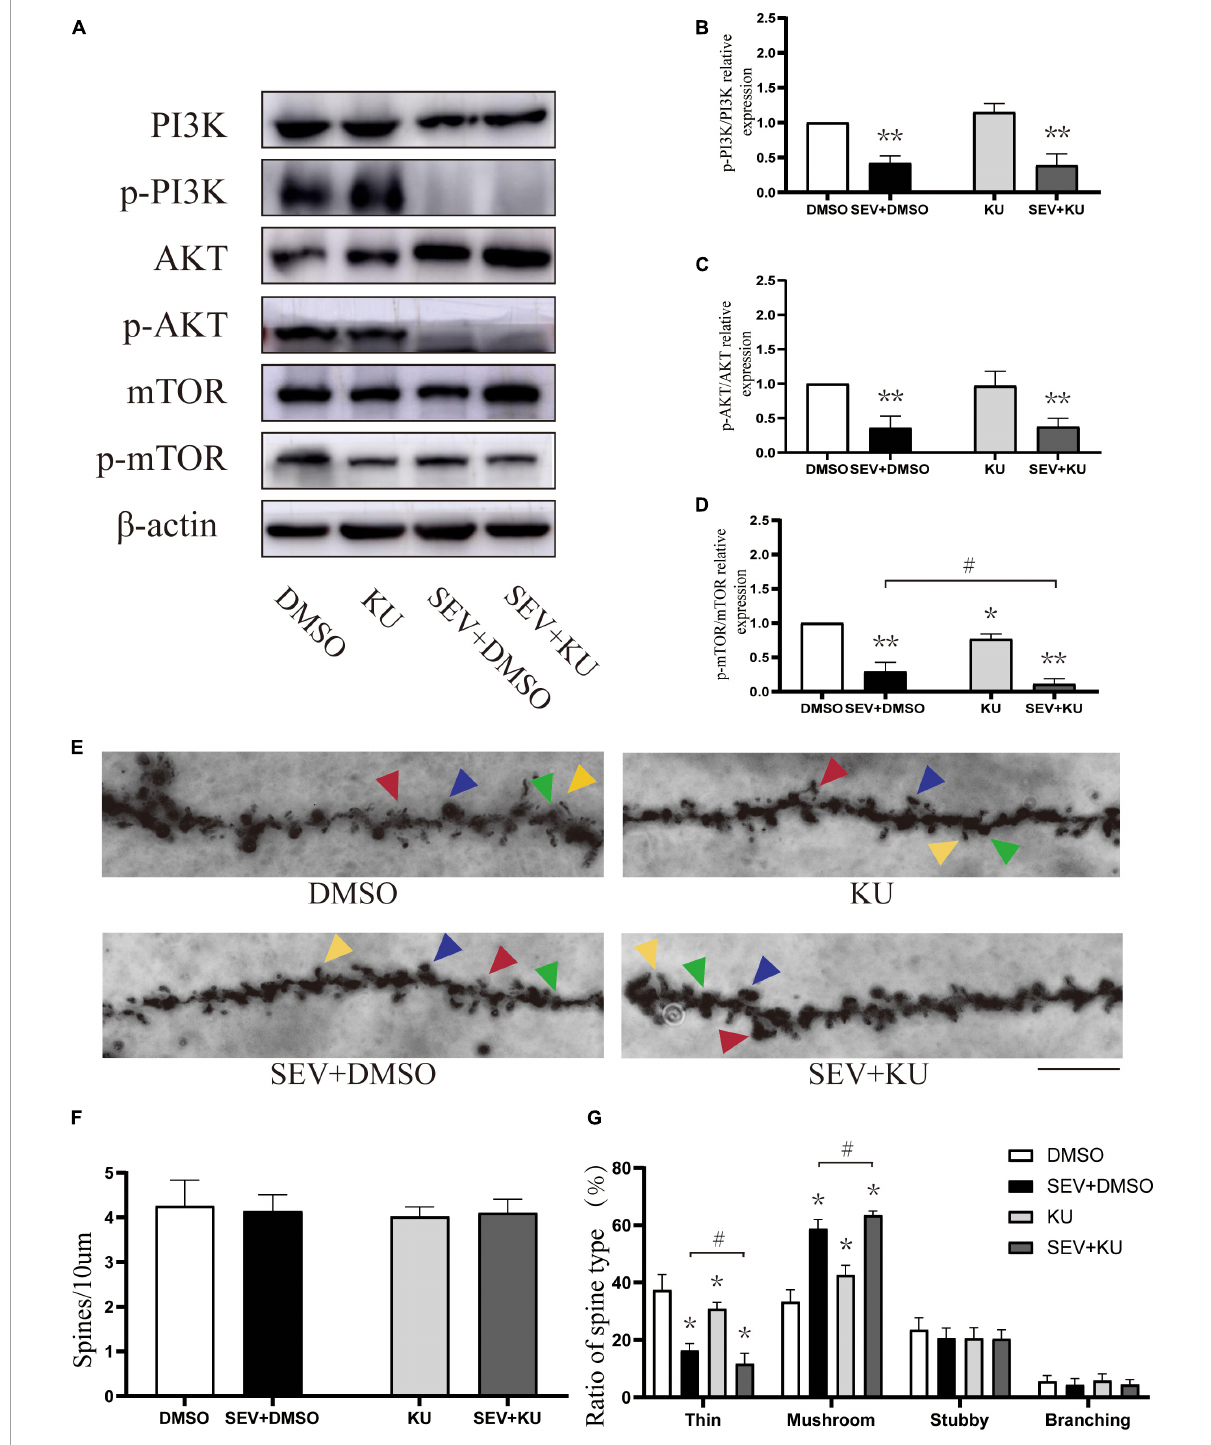
FIGURE5 KU0063794 can aggravate sevoflurane-induced morphological abnormality of dendritic spines. (A) Representative Western blot of phosphorylated and non-phosphorylated proteins for different groups. β -actin was used as reference. (B–D) Normalization of phosphorylated and non-phosphorylated forms. Results of one-way ANOVA and significance are shown inside graphs: data were presented as mean ± SD, n = 6 for per group. (E) Representative images of Golgi staining of dendritic spines in the hippocampi of PND 14 mice in different groups. Different spine types are indicated by relevant color arrowheads: thin spine (yellow), mushroom spine (blue), stubby spine (green), branching spine (red). Scale bar = 10 µ m. (F) The density of the dendritic spine in different groups. (G) The proportion of dendritic spine types in different groups. Data were presented as mean ± SD by one-way ANOVA, n = 6 mice per group. * P < 0.05, ** P < 0.01 vs. DMSO; # P < 0.05 vs. SEV +